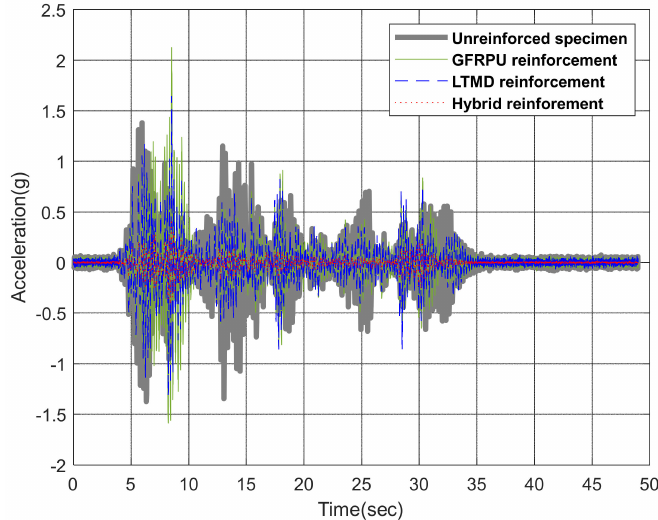
Figure 18. Variation in the acceleration under the 100% El Centro